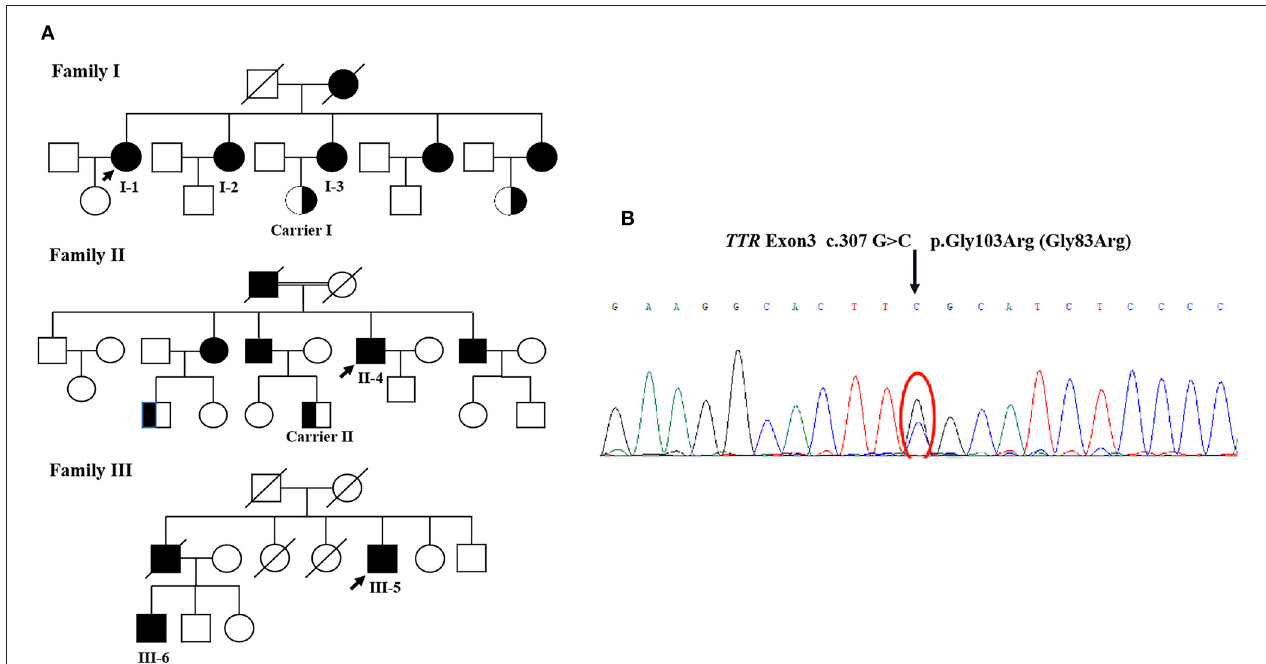
FIGURE 1 | (A) The pedigree of three families. (B) The TTR sequencing results. Sanger sequencing of exons showed a G to C transversion (arrow), resulting in the substitution of glycin-103 by arginine (p.Gly103Arg,